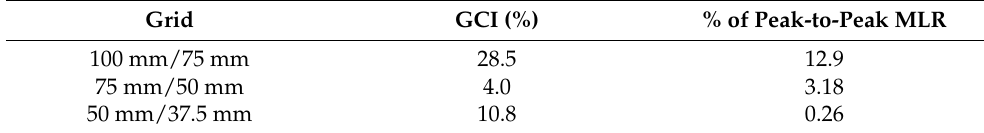
Table 4. Grid convergence and peak-to-peak mass loss rates percentage difference.